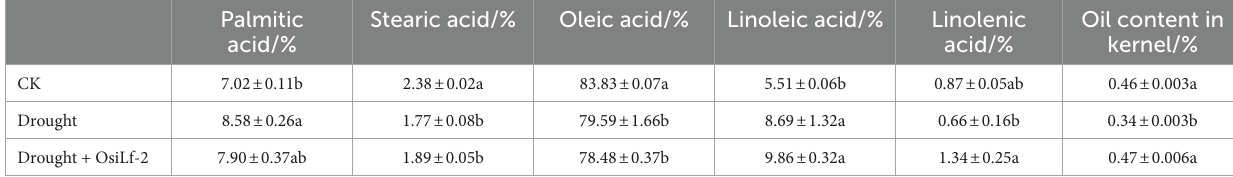
TABLE 2 Effects of different treatment groups on oil quality traits of Camellia oleifera fruit.